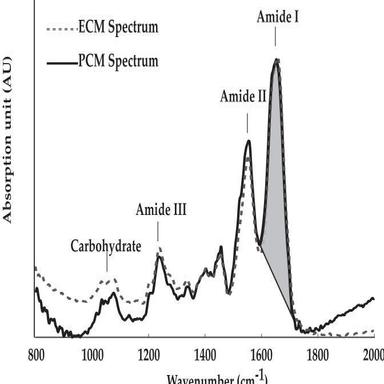
A typical FTIR absorption spectrum with absorption peaks of intact human articular cartilage extracted from a single pixel within the estimated PCM region and the ECM. The shaded area shows the baseline-corrected amide I peak region (1720-1585 cm−1) for the PCM spectrum.